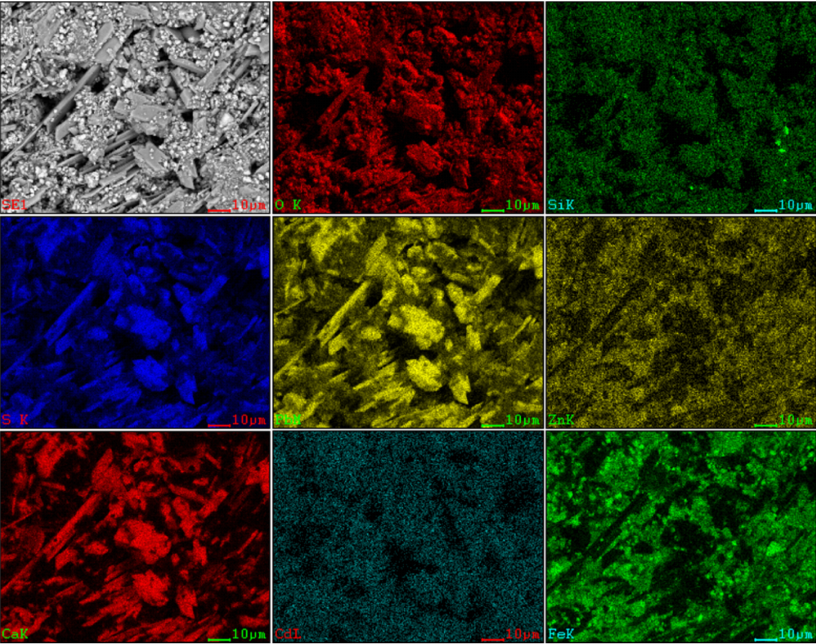
Figure 3. SEM image and EDS mapping analysis of the raw ZOD